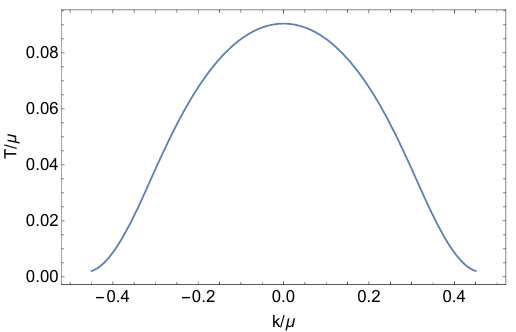
(cid:0) 3 (cid:1) , 3 , 4 , 3 , 1 , 1 , 1 . We see that the most unstable 10 10 10